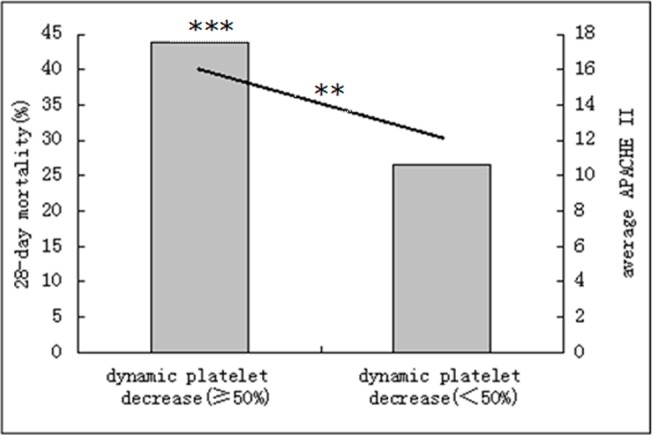
Acute Physiology and Chronic Health Evaluation II (APACHE II) score and 28-day mortality by the dynamic platelet decrease.Bar graph shows 28-day mortality (***p = 0.003). Line graph shows the average APACHE II score (**p = 0.000).